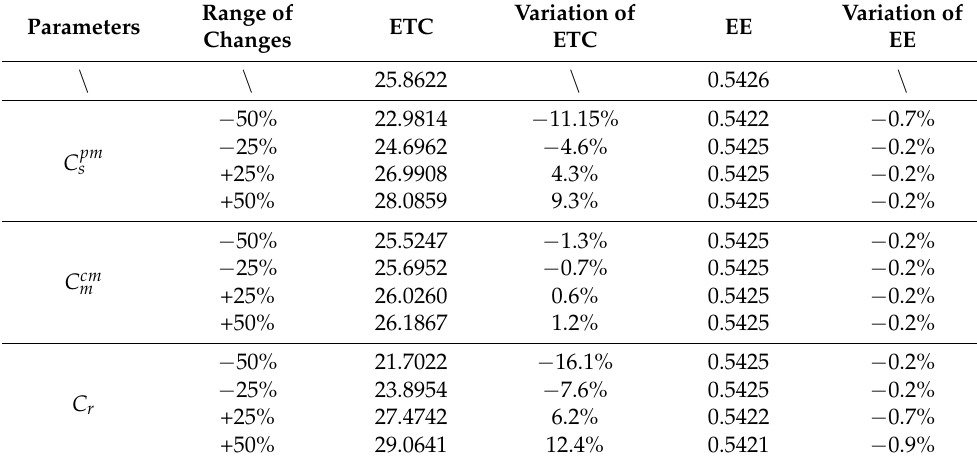
Table 4. Sensitivity analysis